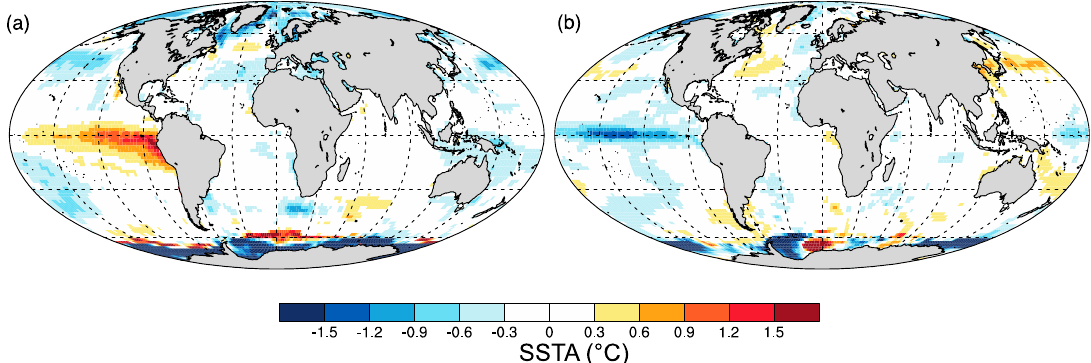
Figure 4. June to July global SSTA during ( a ) driest years in Amhara and Afar (RAI ≤ − 1.0; Years 1982, 1983, 1984, 1987), and ( b ) wettest years in Afar and Amhara (RAI ≥ 1.0; Years 1975, 1988, 1994, 1998).